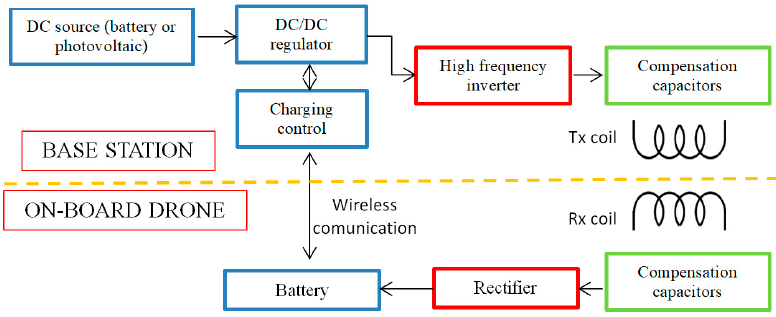
Figure 3. Adopted electrical configuration of the WPT charging for a drone.